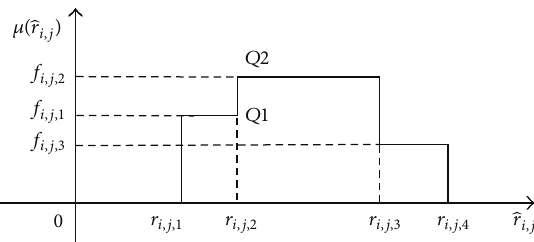
Figure 4: The concept diagram of a three-step preference.